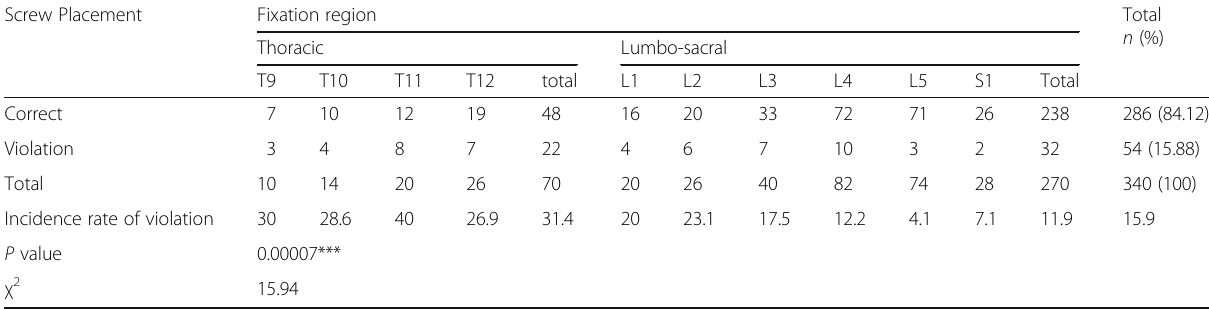
Table 2 Distribution of correctly inserted screws versus violated according to the region of spinal fixation Screw Placement Fixation region